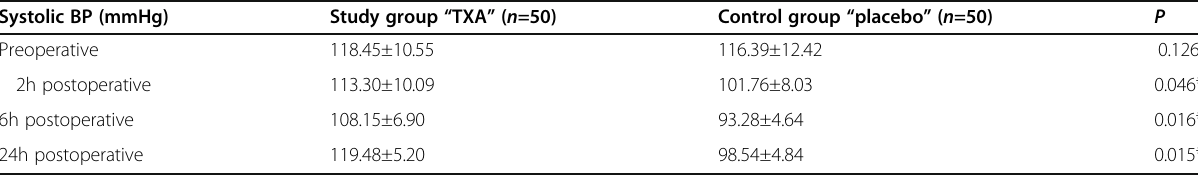
Table 6 Systolic blood pressure (mmHg) in both groups all through the procedure Systolic BP (mmHg)